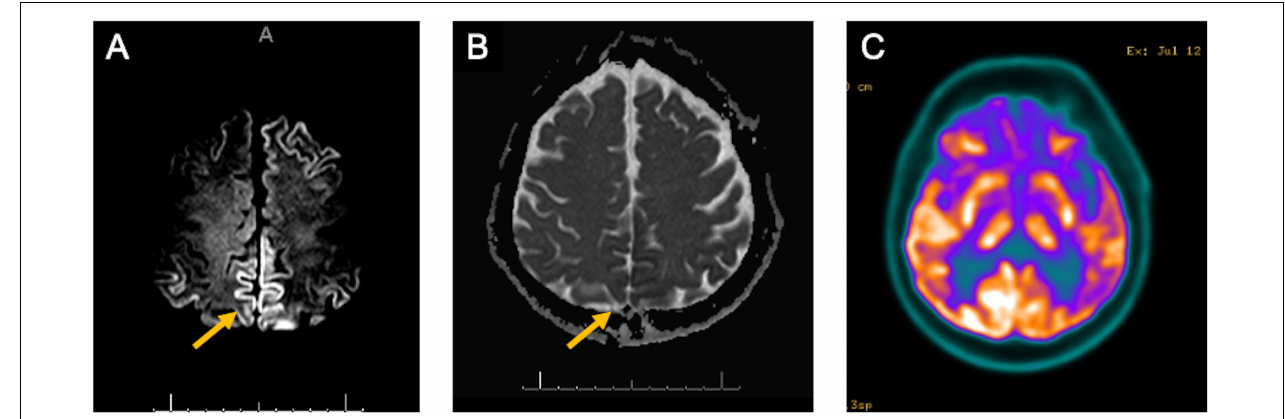
FIGURE 4 | (A) MRI diffusion-weighted images from JJN (case 2) revealing hyperintensities on frontal, temporoparietal and posterior cingulate cortical areas ( A , yellow arrow); (B) MRI apparent diffusion coefficient maps with corresponding hypointensities in the same regions above ( B , yellow arrow); (C) 18-FDG PET/CT shows hypometabolism on the bilateral temporoparietal cortex, posterior cingulate, precuneus, and caudate nucleus.